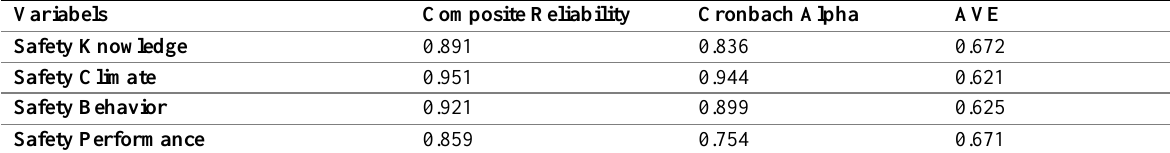
Table 1: Composite Reliability, Cronbach Alpha,